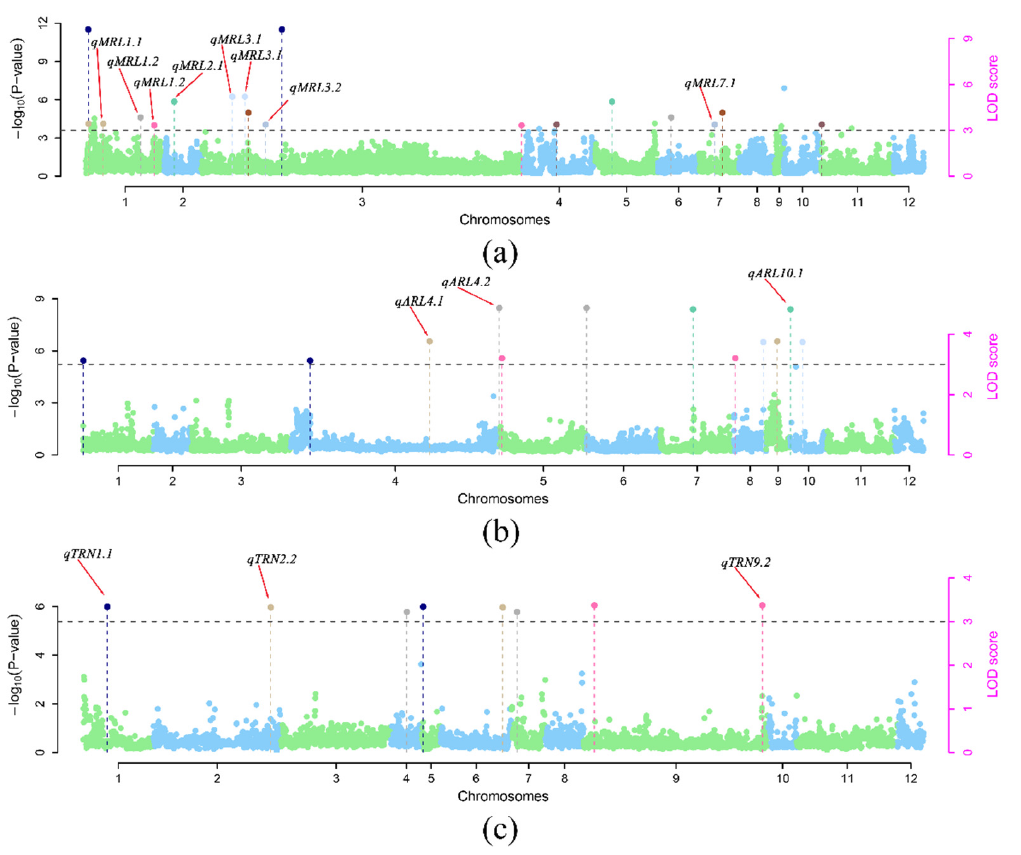
Figure 6. Manhattan plots of epistatic interaction among the loci of MRL, ARL, and TRN. Manhattan plots of epistatic interactions at the main effect sites of MRL ( a ), ARL ( b ), and TRN ( c ). The red arrow represents the QTLs co-localized by GLM, MLM, and epistatic interactions. The − log 10 ( p ) value is reported on the left y-axis, which was obtained from the whole genome scanning of all markers in 3VmrMLM. The LOD score is reported on the right y-axis, which was obtained from the significant likelihood ratio test and suggested the dominant locus in the second step of 3VmrMLM, with the threshold LOD = 3.0 (black dotted line). If LOD score ≥ 20, the LOD scores obtained are transformed as LOD ′ = 20 + (LOD − 20)/100. These LOD scores, along with their known genes, are shown in points with straight lines. All the main-effect genes with grey and blue characters are identified in one and at least two datasets. All the genes with underline are around suggested loci.